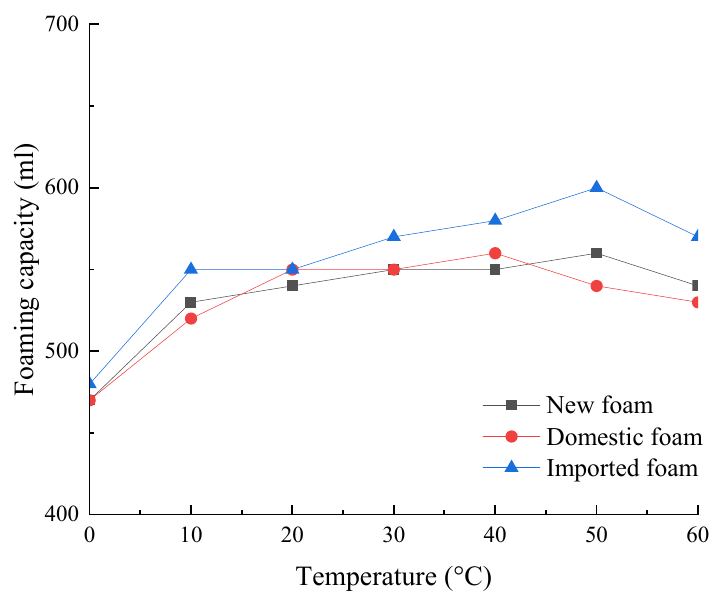
Figure 10. Foaming Amount of Three Foams at Different Temperatures.